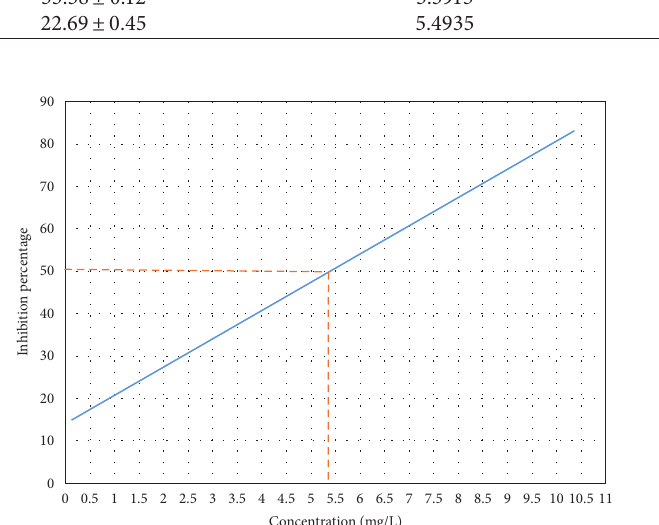
Figure 2: Plot of inhibition percentage with respect to concentration (mg/L) of triplicated measurements in two separate sample runs of the Artocarpus heterophyllus extract.